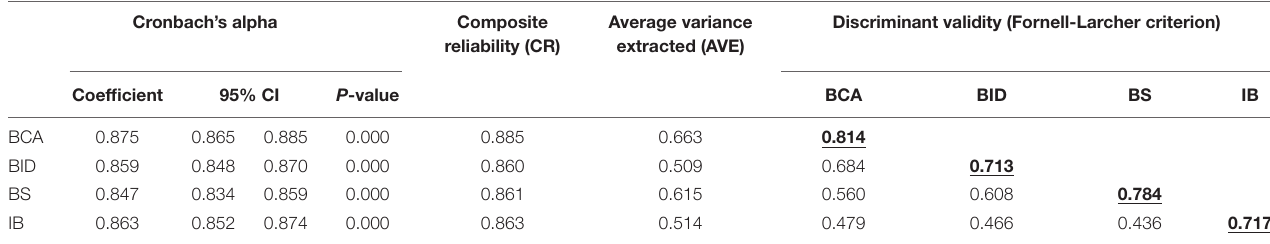
TABLE 1 | Constructs reliability and validity, and discriminant